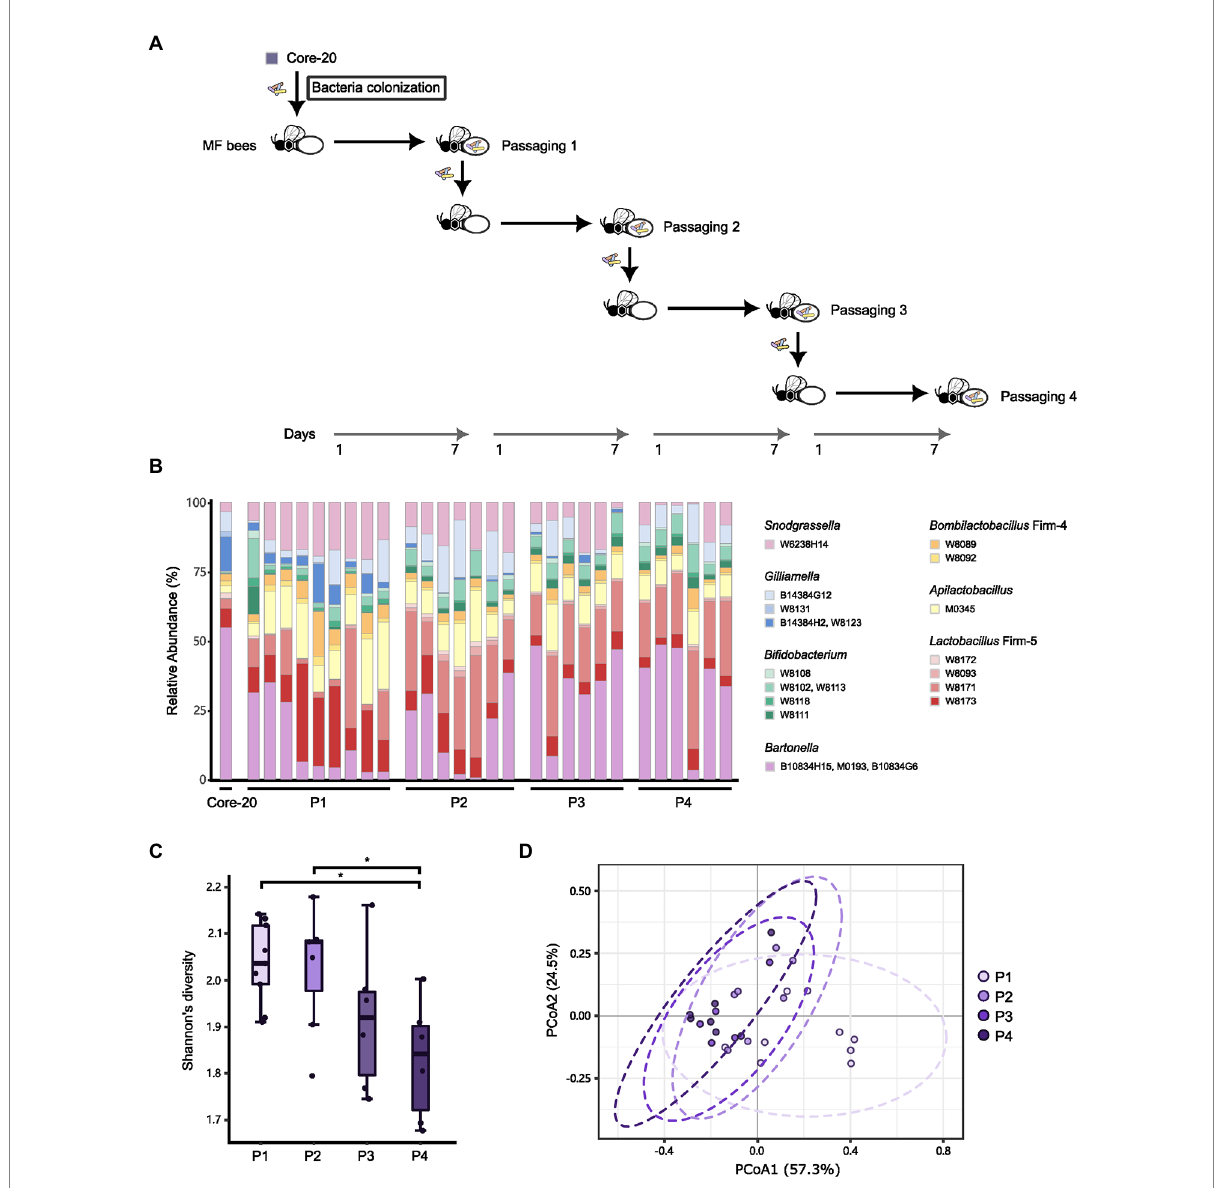
FIGURE 6 The Core-20 community stably colonized honeybees for four passages. (A) Experimental design for passaging transmission. (B) Relative abundance of strains in the Core-20 during four passages. All strains except G. sp. W8131 were detected individually in bee gut samples among passages. (C) Box plots of Shannon’s alpha diversity index at each passage. Results showed a slight decrease in alpha diversity. (D) Principal coordinates analysis (PCoA) plot of Bray–Curtis dissimilarity among samples. We found that the last three passages showed community similarity except for